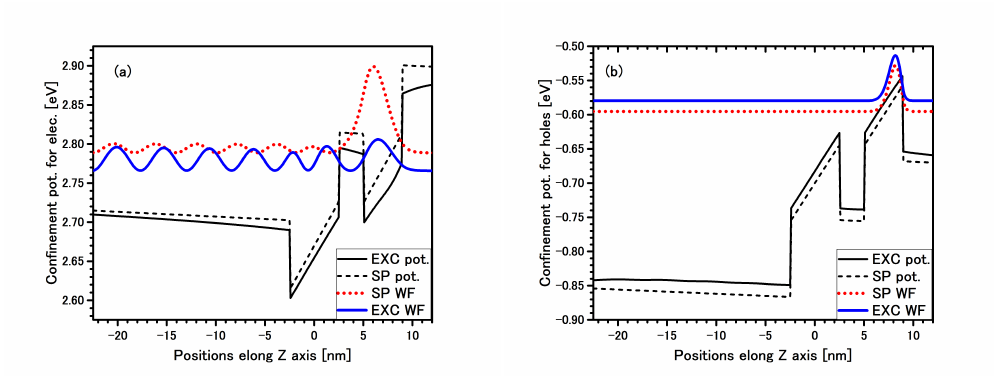
Figure 5. Band edge profile potentials (black lines) with single particle (SP) wave-function (WF) (dotted red line) and excitonic multiplier of the WF (solid blue line) for electron ( a ) and hole ( b ) for direct EL2 exciton in QW 4nm are presented in the structure #2. Solid black lines are confined potential with additional Coulomb term (Equation (7)).